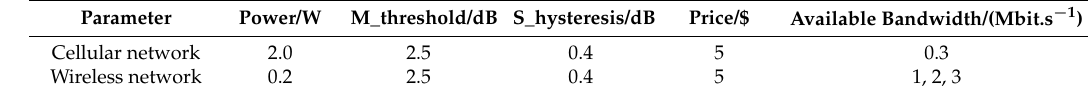
Figure 7. The integrated network congestion rate with larger wireless network bandwidth. The network revenue increases with the increase in the number of users, which is shown in Figure 8. For a user i , assuming the communication load is i T and the network price is p , the network income generated by user i is i T p × . There are n users in total on the network at this time. Therefore, the total network income is